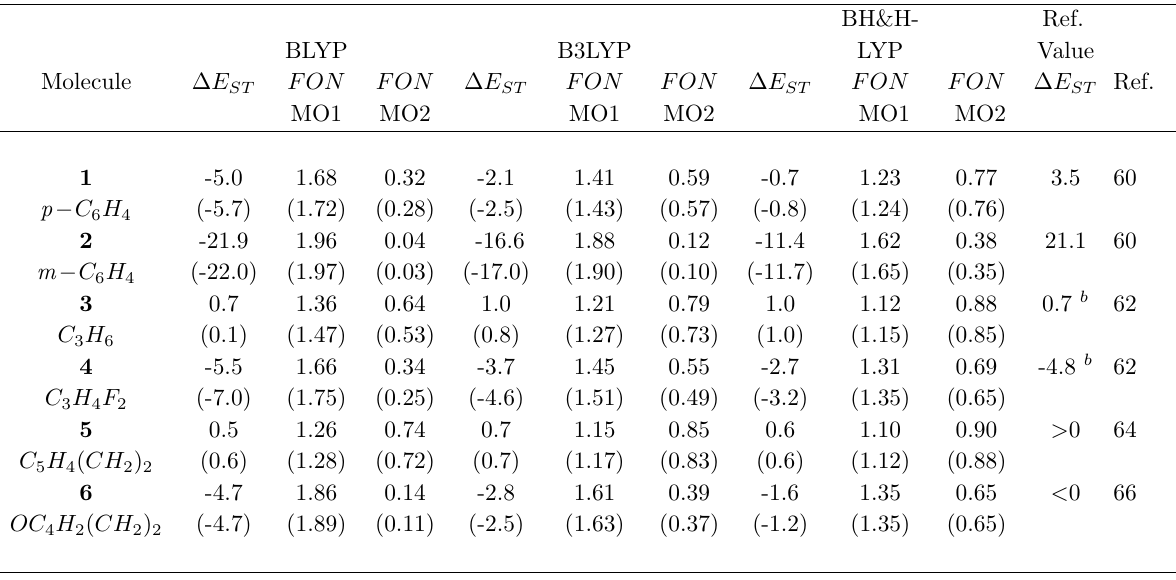
Table 2. Singlet-triplet energy splitting ∆ E ST and fractional occupation numbers (FON) of orbitals as calculated with the REKS(2,2) method using different functionals and basis sets.